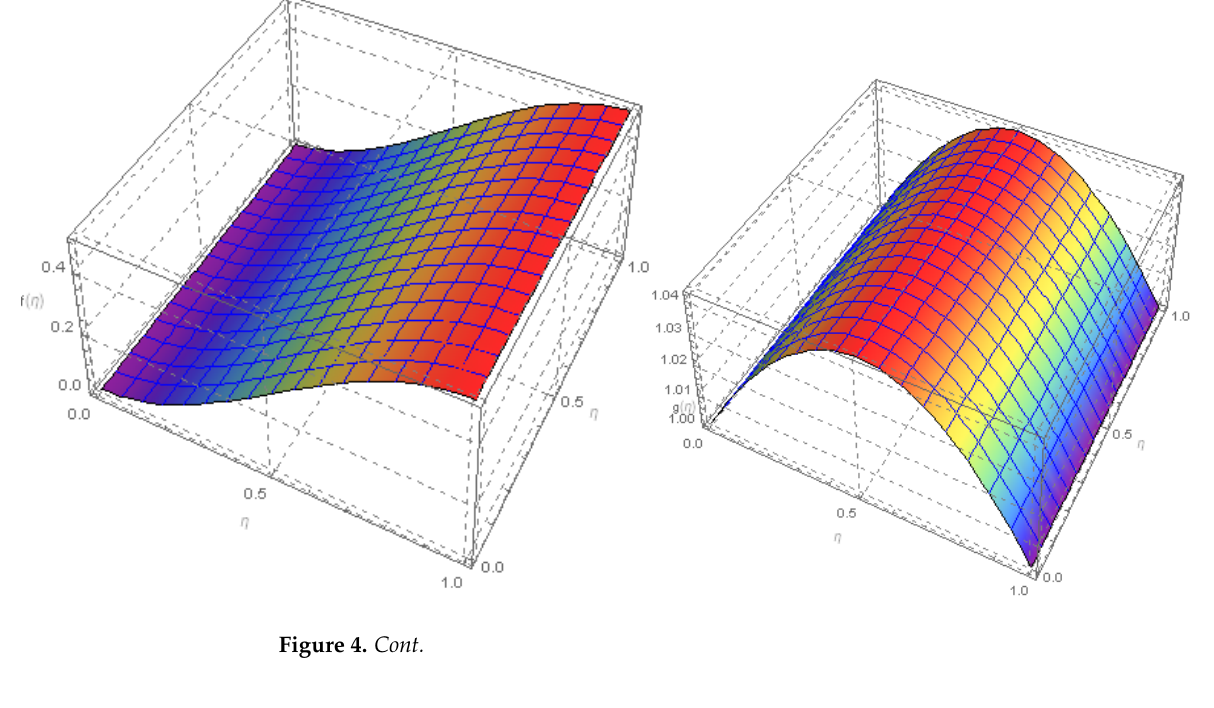
Figure 3. Error profile for f ( η ) , g ( η ) , m ( η ) , and n ( η ) , with fixed S z = − 0.1, M x = 0.1, M y = 0.3, R m = 0.01, and S = 1.